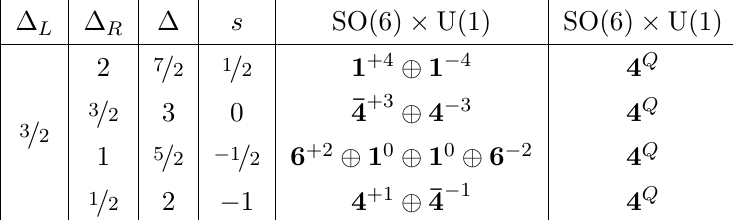
Table 7. Mass spectrum for the SU(4 group U(4 ;